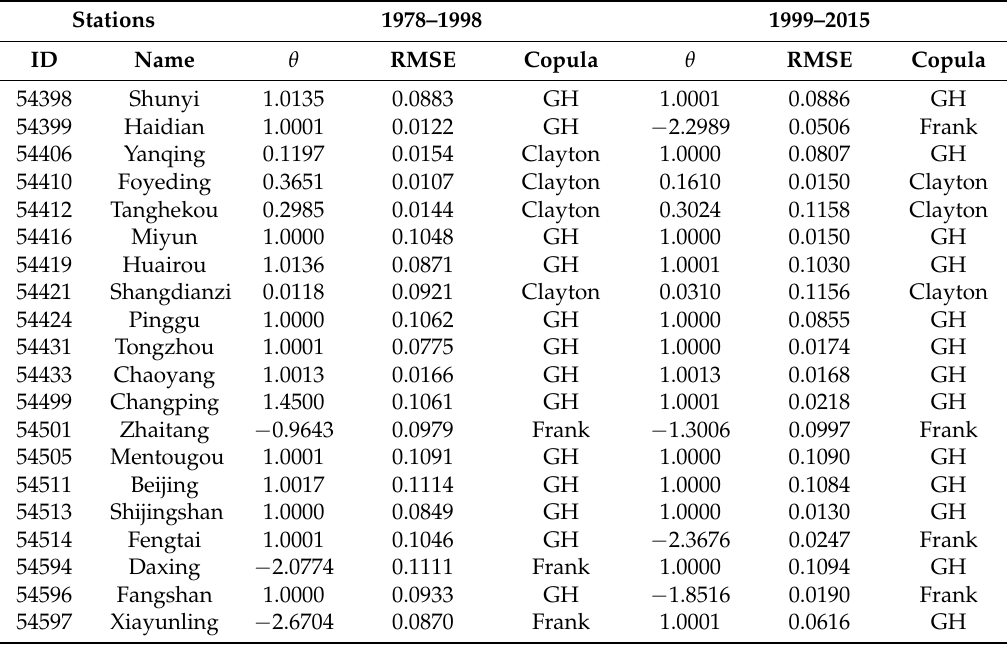
Table 5. Parameter estimation and root-mean-square error (RMSE) for selected copula distributions for 20 meteorological stations in Beijing.